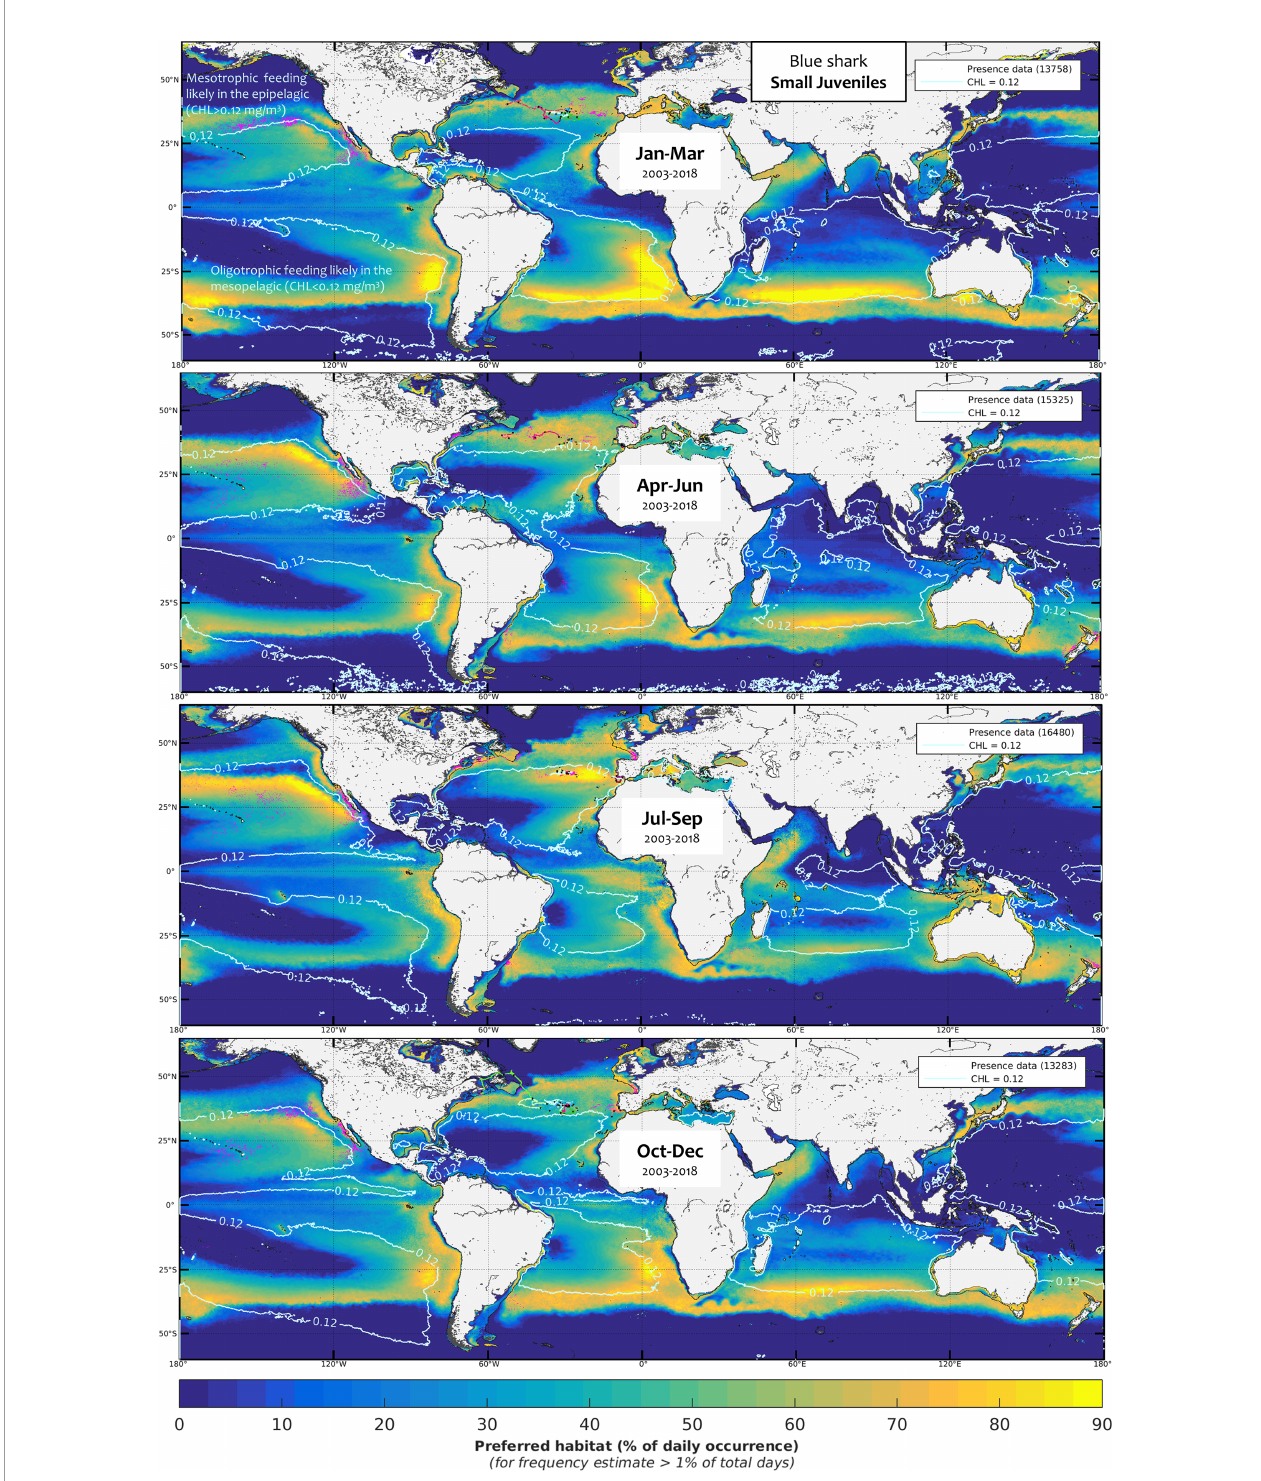
FIGURE 5 | Mean seasonal distribution of blue shark foraging habitat for the small juveniles (SJ, 2003-2018, in frequency of suitable habitat occurrence, %). The chlorophyll-a isocontour of 0.12 mg.m -3 ( CHL min ) separates the mean area of oligotrophic foraging (below this value using mesopelagic micronekton as foraging proxy) and mesotrophic foraging (above this value using productivity fronts). Presence data (calibration and validation) are represented as pink dots for observer data and colored line transects for electronic tagging data (start and end of months are shown by a black star).